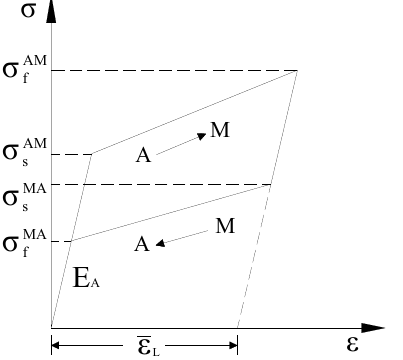
Figure 2. Stress–strain curve of the SMA wire [26].